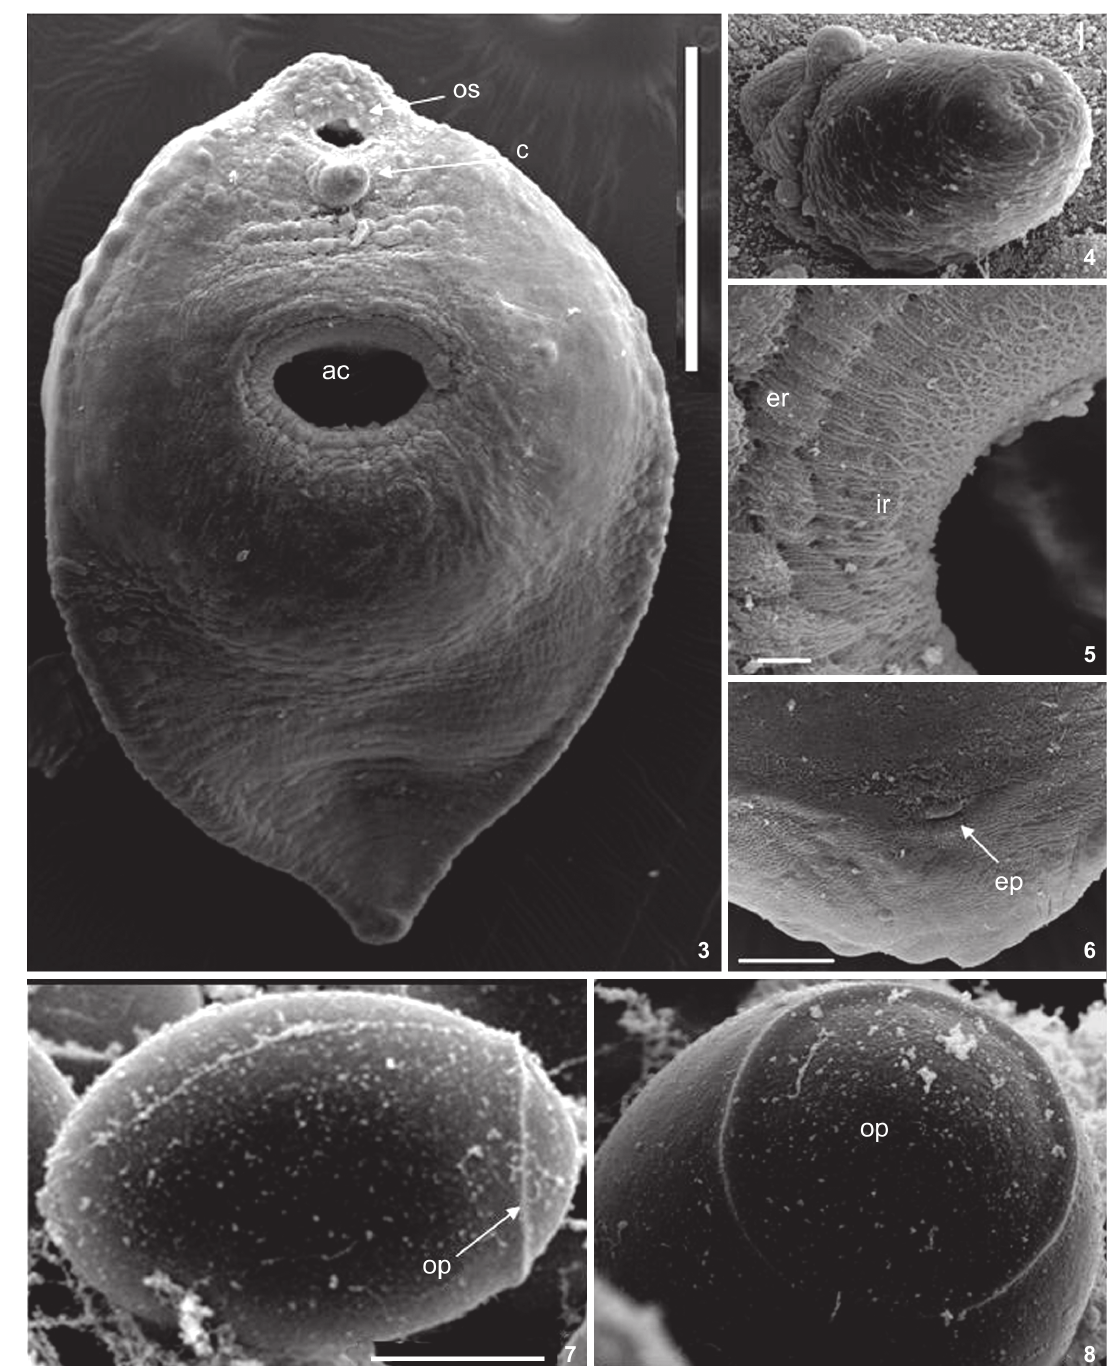
3 Figures 3-8. Scanning electron microscopy (SEM) of Cannania obesa (3), ventral view showing oral sucker (os), cirrus (c) and acetabu- lum (ac); (4) detail of the unarmed cirrus (c); (5) detail of the acetabulum border formed by the external and internal rings with a filamentous network tegument; (6) excretory pore (ep) at the posterior region; (7-8) egg showing prominent suture of the opercula and knob structure at opposite extremity. Scale bars: 3 = 500 µm, 3-5 and 7-8 = 10 µm, 6 = 50 µm.